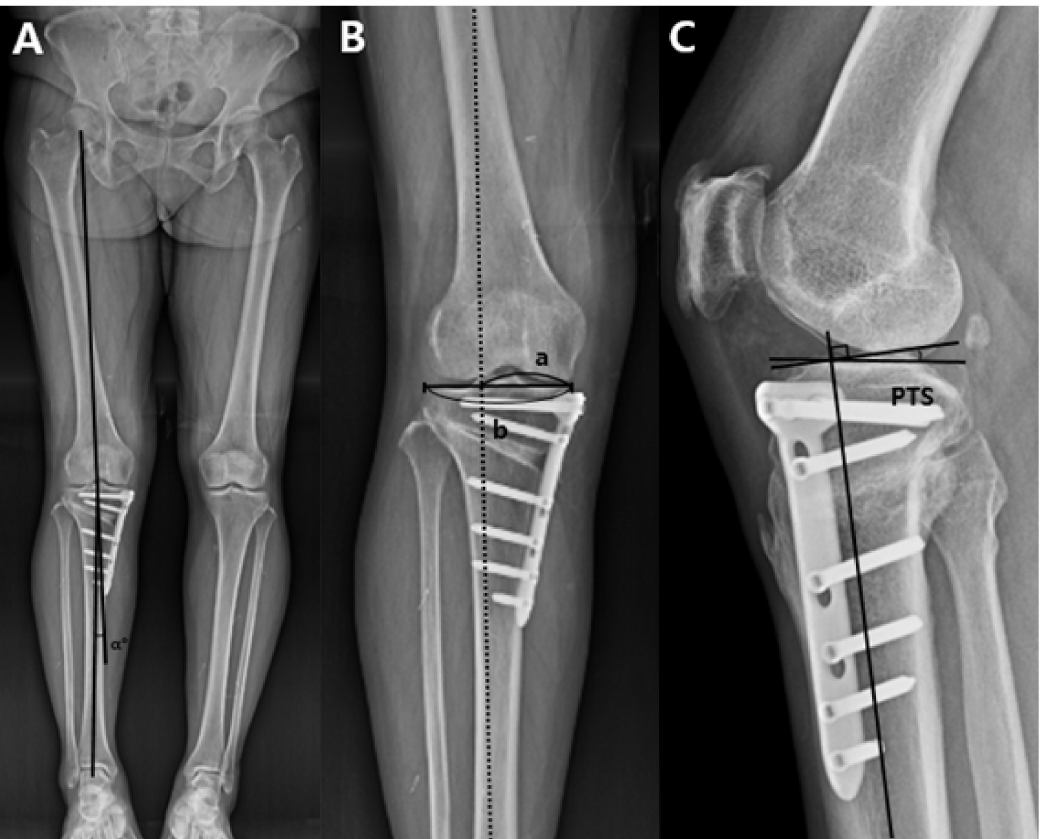
Figure 4. Measurement of the hip-knee-ankle angle, weight-bearing line ratio, and posterior tibial slope on the plain radiographs. ( A ) The hip-knee-ankle angle ( α ◦ ) is formed by the first line drawn from the center of the femoral center to center of the tibial spine and the second line drawn from the center of the tibial spine of knee joint to the center of the superior articular surface of the talus in the ankle joint. The angle made by the intersection of these two lines was defined as the hip-knee-ankle angle. ( B ) The weight-bearing line was drawn from the center of the femoral head to the middle point of the superior articular surface of the talus on the full-length lower extremity standing radiograph. A tibial plateau line from the medial edge to the lateral edge of the proximal tibia on the joint surface was drawn thereafter. Weight-bearing line ratio (a/b) was calculated as the ratio of the distance from the medial edge of the proximal tibial plateau to the intersection of the weight-bearing line and the proximal tibial plateau line (a) to the entire length of the proximal tibial plateau line (b). The medial tibial edge was 0%, and the lateral tibial edge was 100%. ( C ) The posterior tibial slope is formed by the perpendicular line to the tibial shaft axis and the medial tibial plateau line on the true lateral view. posterior tibial slope = posterior tibial